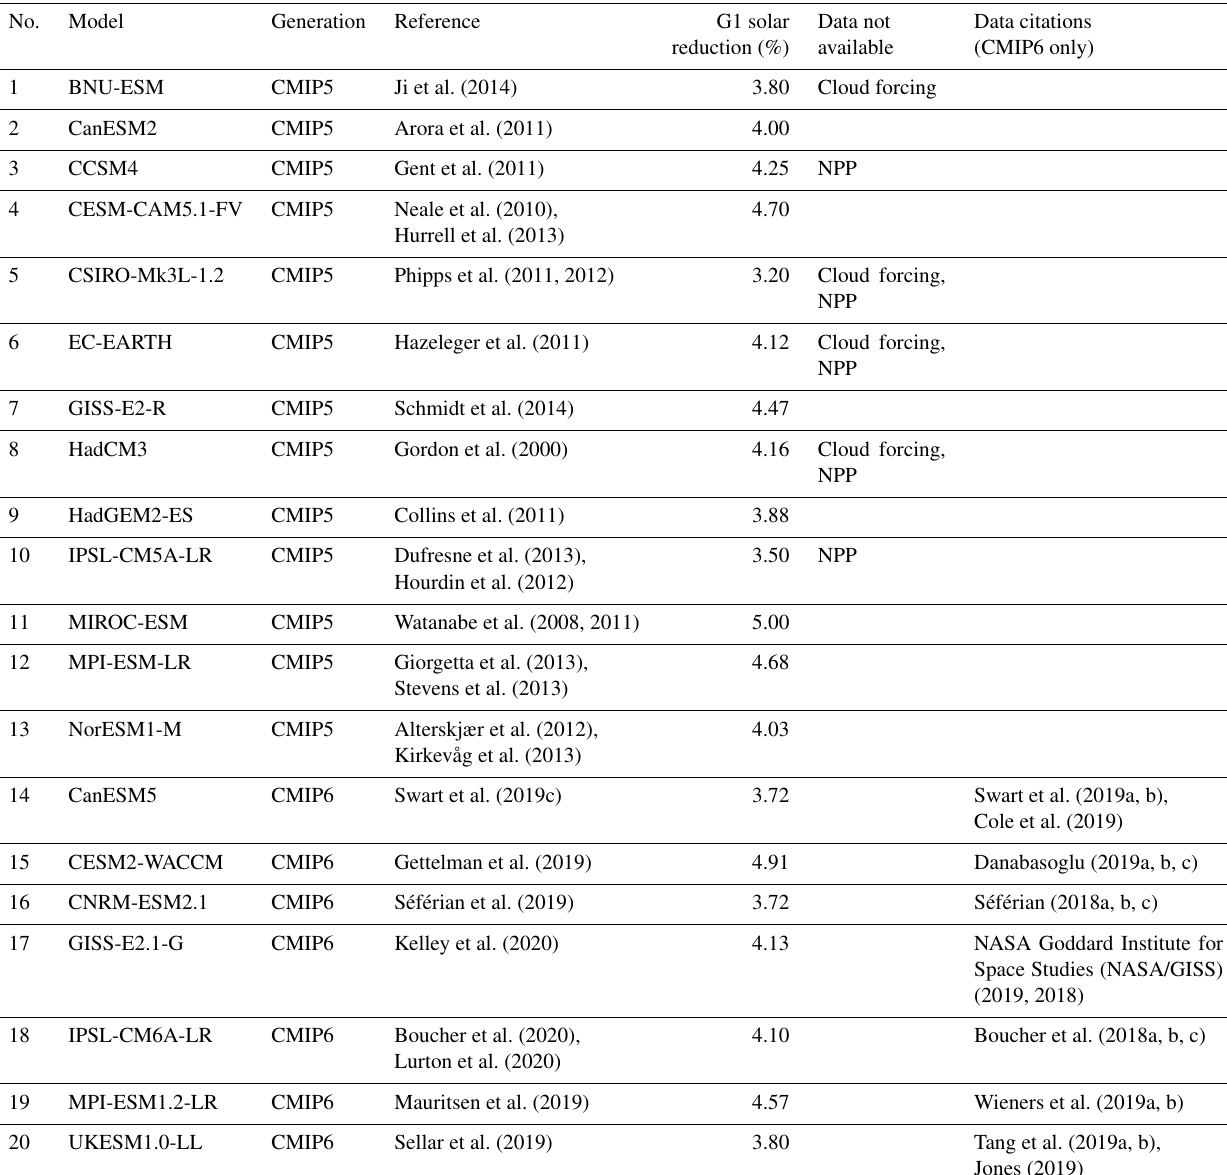
Table 1. All participating models in both the CMIP5 and CMIP6 eras of GeoMIP, including references. For G1 solar reduction, the percentage is calculated as the percent change in incident solar irradiance at the TOA between G1 and its respective piControl run. Numbers in the first column correspond to the model numbers in Fig.